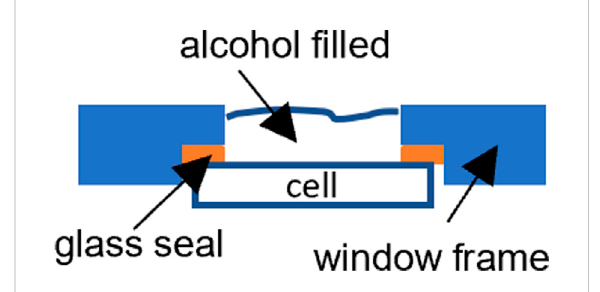
FIGURE 1 Schematicdrawingshowingtheleaktestofaplanarcellglass sealed onto a metal window